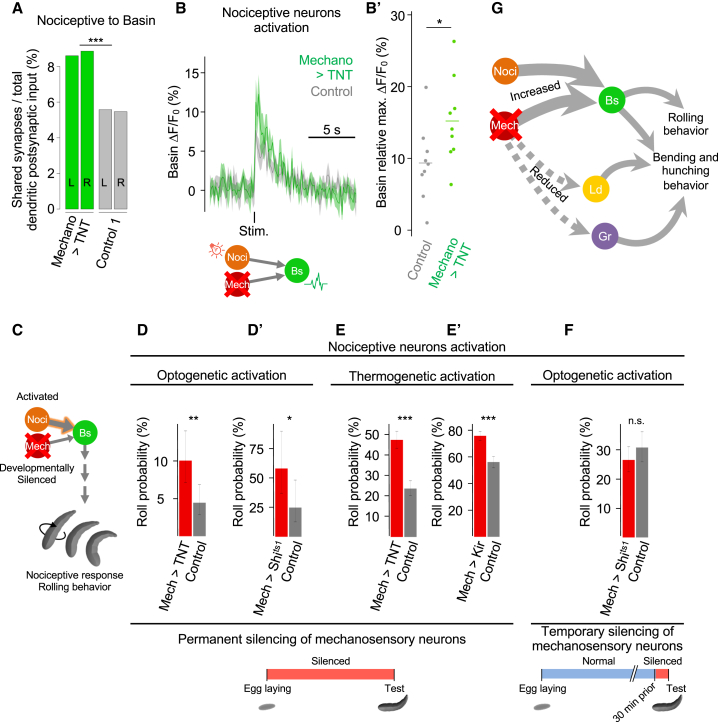
Bs Interneurons Compensate for Lack of Me Input by Increasing Nociceptive Input(A) Fraction of input from nociceptive neurons onto Bs interneurons increases when Me neurons are silenced by the targeted expression of TNT, compared with control. ∗∗∗p < 0.001, chi-square test.(B) Calcium responses (mean ± SEM) of Bs interneurons to optogenetic activation of nociceptive neurons when Me neurons are silenced (mechano > TNT).(B′) Quantification of calcium responses in (B). n = 9 animals for each condition. ∗p < 0.05, single-sided Wilcoxon rank-sum test.(C) Schematic of behavioral experiments in which the Me neurons (mech) were temporarily or permanently silenced, and the nociceptive neurons (noci) were activated. Strong nociceptive activation can elicit rolling (Ohyama et al., 2015).(D–F) Rolling probabilities upon activation (optogenetic in D, D′, and F; thermogenetic in E and E′) of nociceptive neurons and permanent (D–E′) or temporary (F) silencing of Me neurons (mech). Silencing achieved by targeted expression of TNT (D and E), Shits1 (D′ and F), or Kir (E′). Note that genotypes in (B) and (D) are the same. For (D): experimental, n = 298 animals; control, n = 426. For (D′): experimental, n = 310; control, n = 322. For (E), experimental, n = 550; control, n = 526. For (E′): experimental, n = 580; control, n = 512. For (F): experimental, n = 399; control, n = 305. Error bars represent 95% confidence interval. ∗p < 0.05, ∗∗p < 0.01, and ∗∗∗p < 0.001, chi-square test.(G) Summary of connectivity and behavioral effects of the developmental silencing of Me neurons. Abbreviations as in Figure 1C.See also Tables S1 and S2, Data S3, and Figure S6.